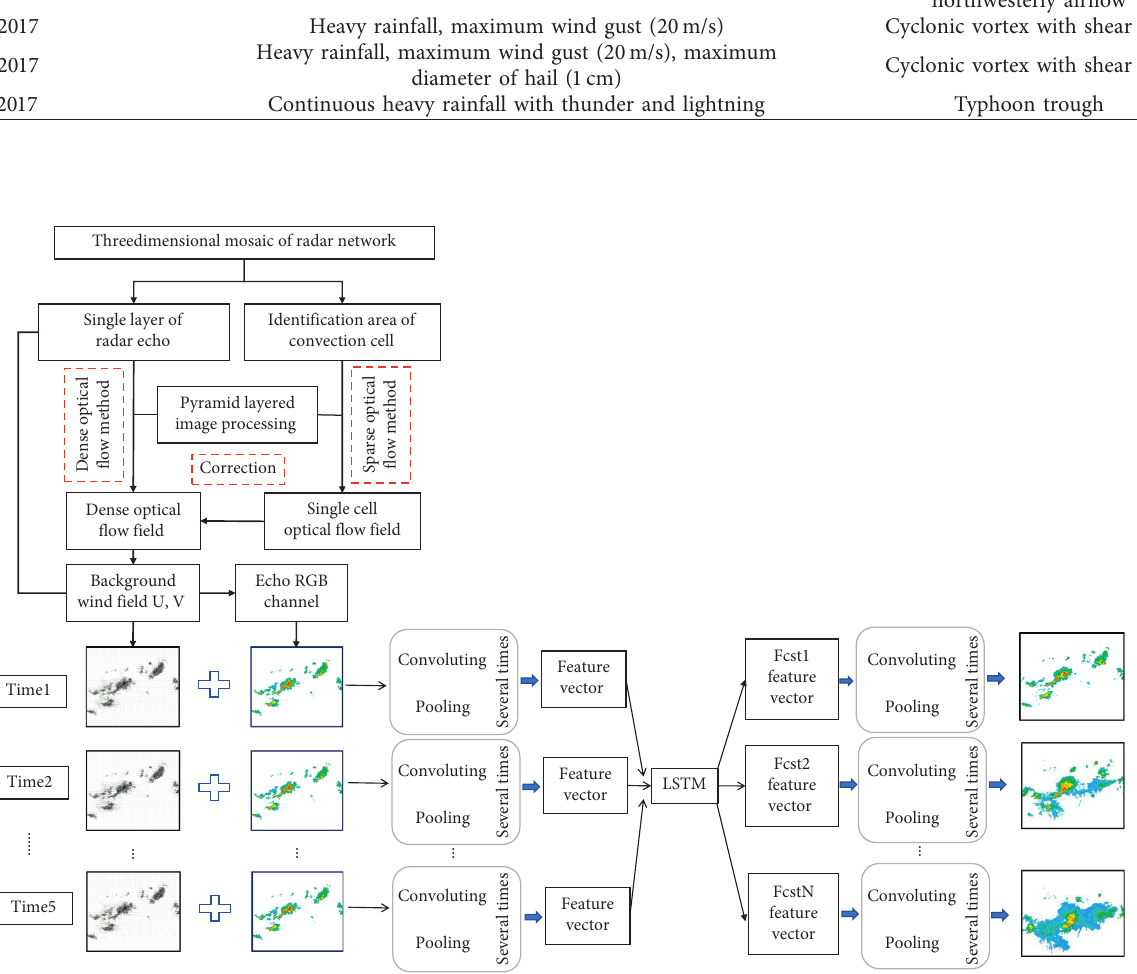
Figure 2: Flowchart of the convective echo extrapolation algorithm based on ConvLSTM machine learning.